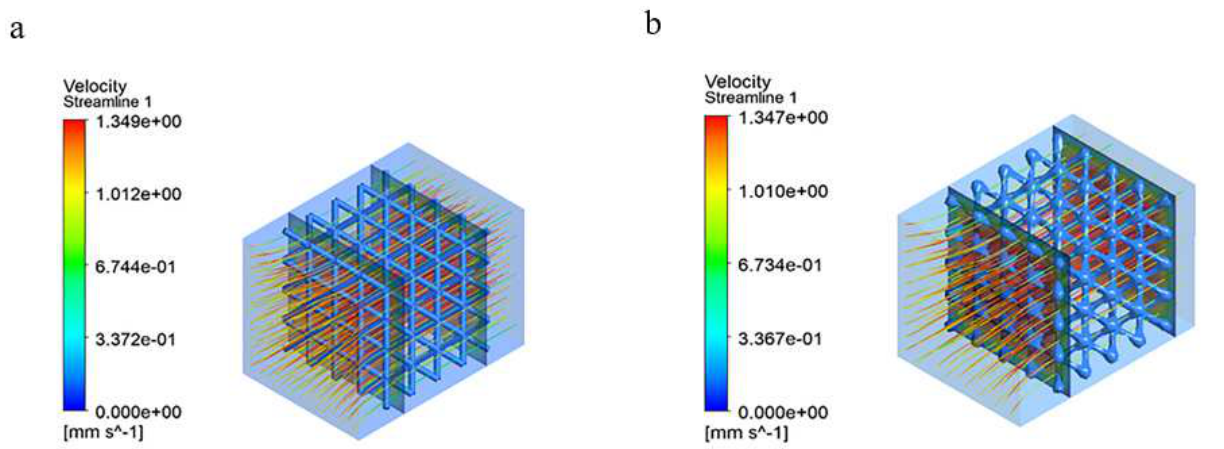
Figure 7. Two groups of scaffolds’ velocity clouds: ( a ) conventional BCC Structure and ( b ) optimized BCC Structure.